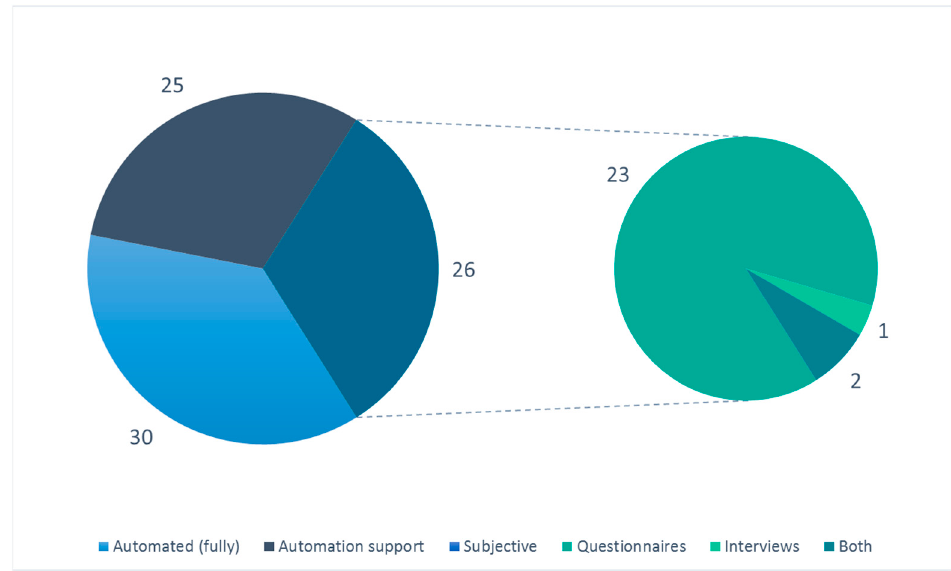
Figure 5. Analysis of metrics explored through user testing.